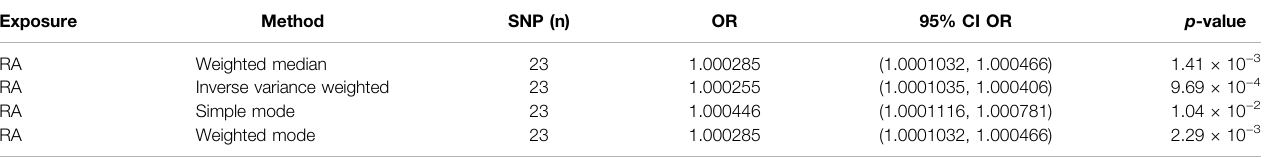
TABLE 1 | Mendelian randomization analysis results of causal effects from RA to mechanical complication of prosthesis. Exposure